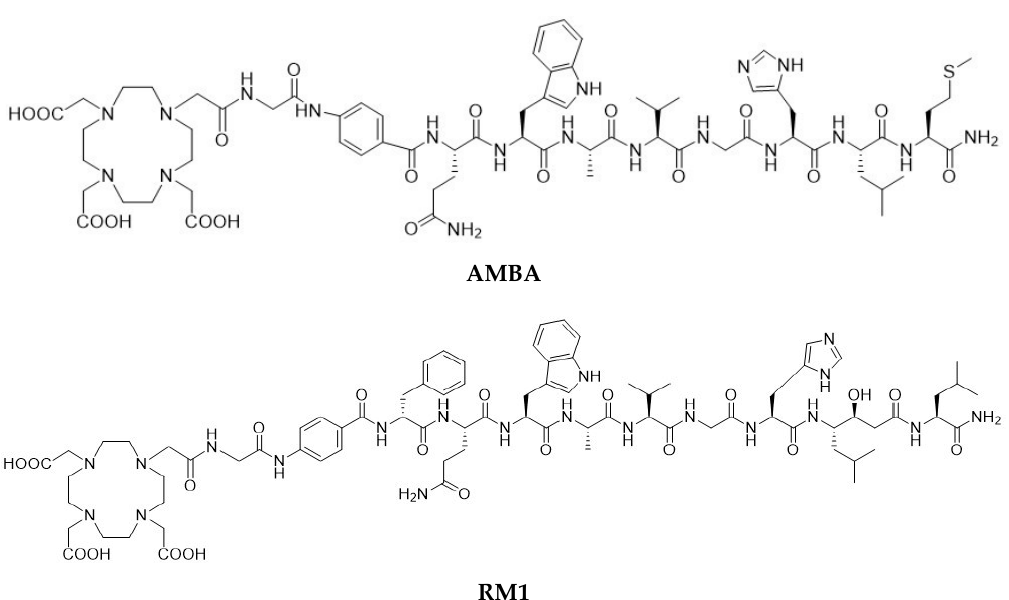
Figure 1. Structure of DO3A-CH2CO-G-[4-aminobenzyl]- Gln-Trp-Ala-Val-Gly-His-Leu-Met-NH 2 (AMBA) and DO3A-CH 2 CO-G-[4-aminobenzyl]- D-Phe-Gln-Trp-Ala-Val-Gly-His-Sta-Leu-NH 2 (RM1).